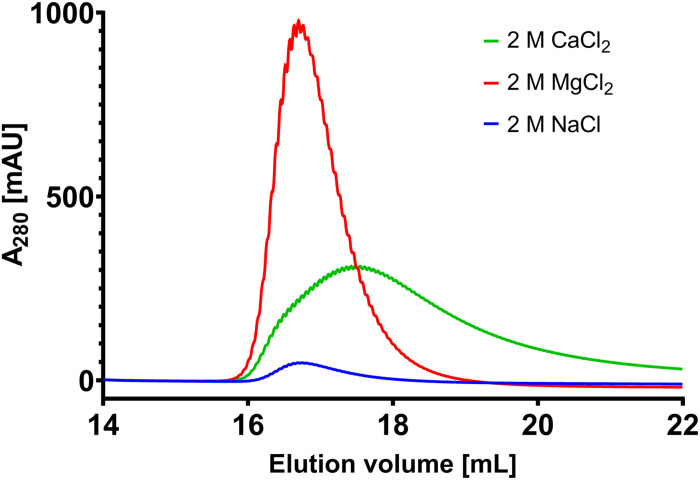
Selectivity test of M9 toward CaCl2, NaCl and MgCl2. Depiction of the elution of 2 mg Gamunex bound to immobilized M9 by 2 M NaCl (blue), 2 M CaCl2 (green) or 2 M MgCl2 (red), respectively. Recovery as determined by the AUC was 98.8% for MgCl2, 79.3% for CaCl2 and 8.2% for NaCl, respectively.